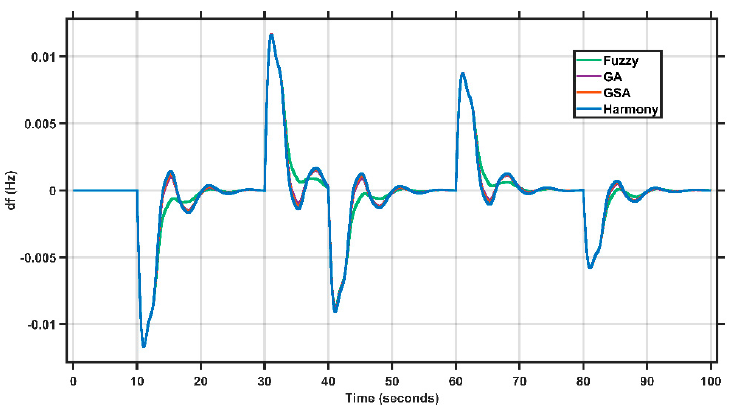
Figure 12. The frequency deviation under dynamic disturbance.